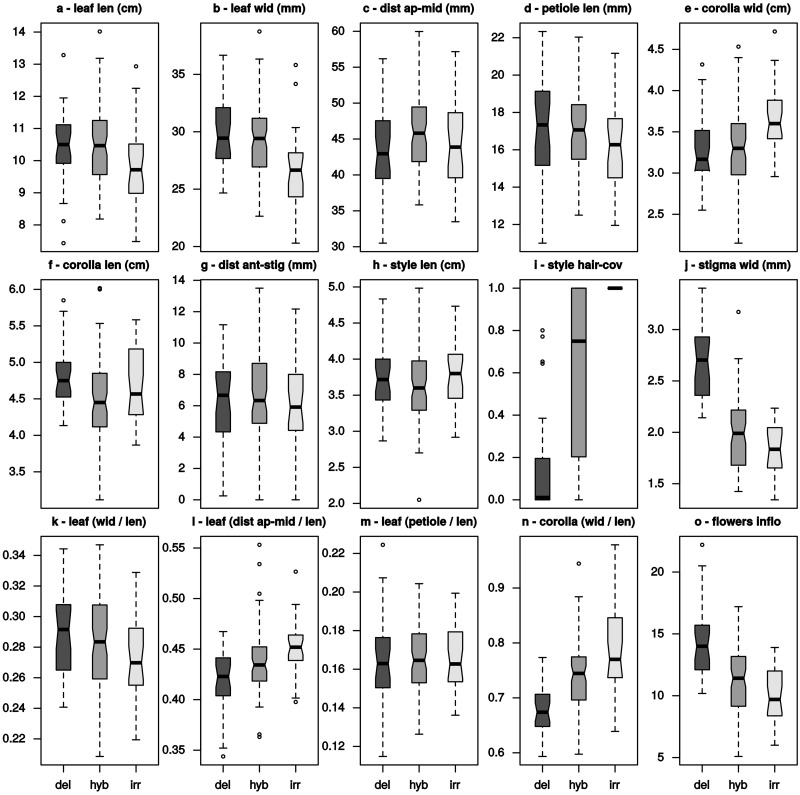
Ranges of means for the quantitative characters measured. Boxplots showing the ranges of observed means (trimmed means, calculated from repeated measurements of the same individual) for the measured quantitative characters and derived ratios of the two parental species R. delavayi (del) and R. irroratum (irr) and intermediates (hyb). Horizontal black lines indicate the median and notches the 95 % quartiles, hence non-overlapping notches can be interpreted as significant difference. Notches are not shown for style hair-coverage (i), as the distribution of this percentage measure is too skewed in the parental species.